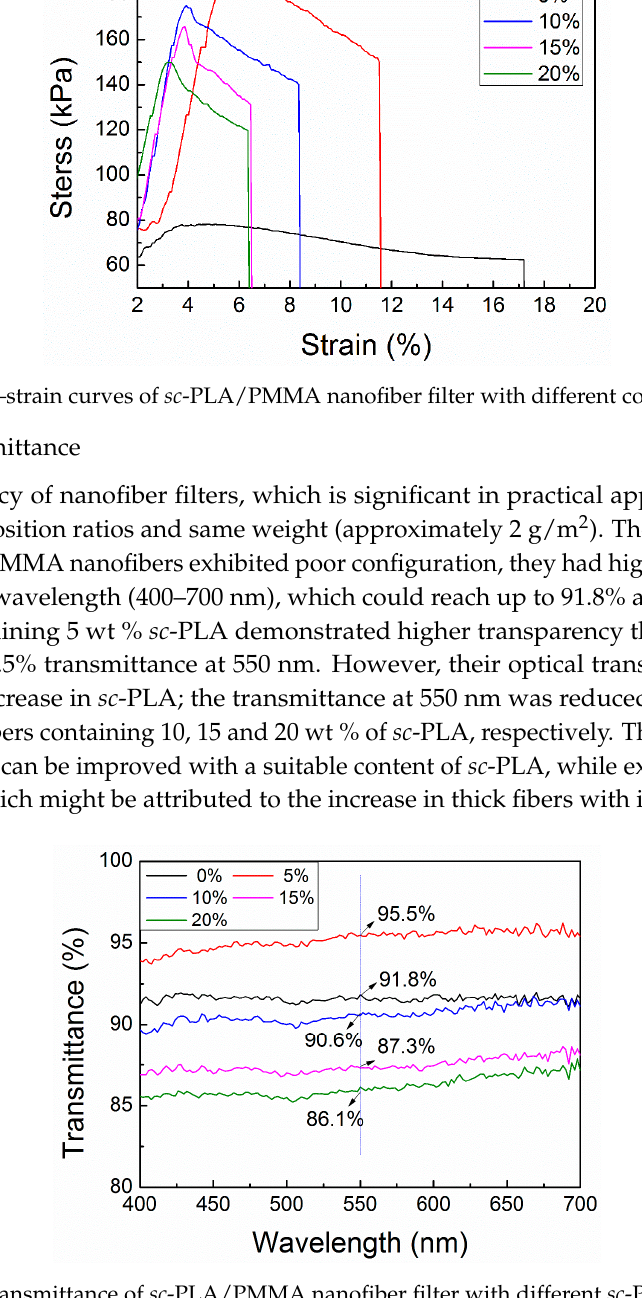
Figure 5. Transmittance of sc -PLA/PMMA nanofiber filter with different sc -PLA contents.